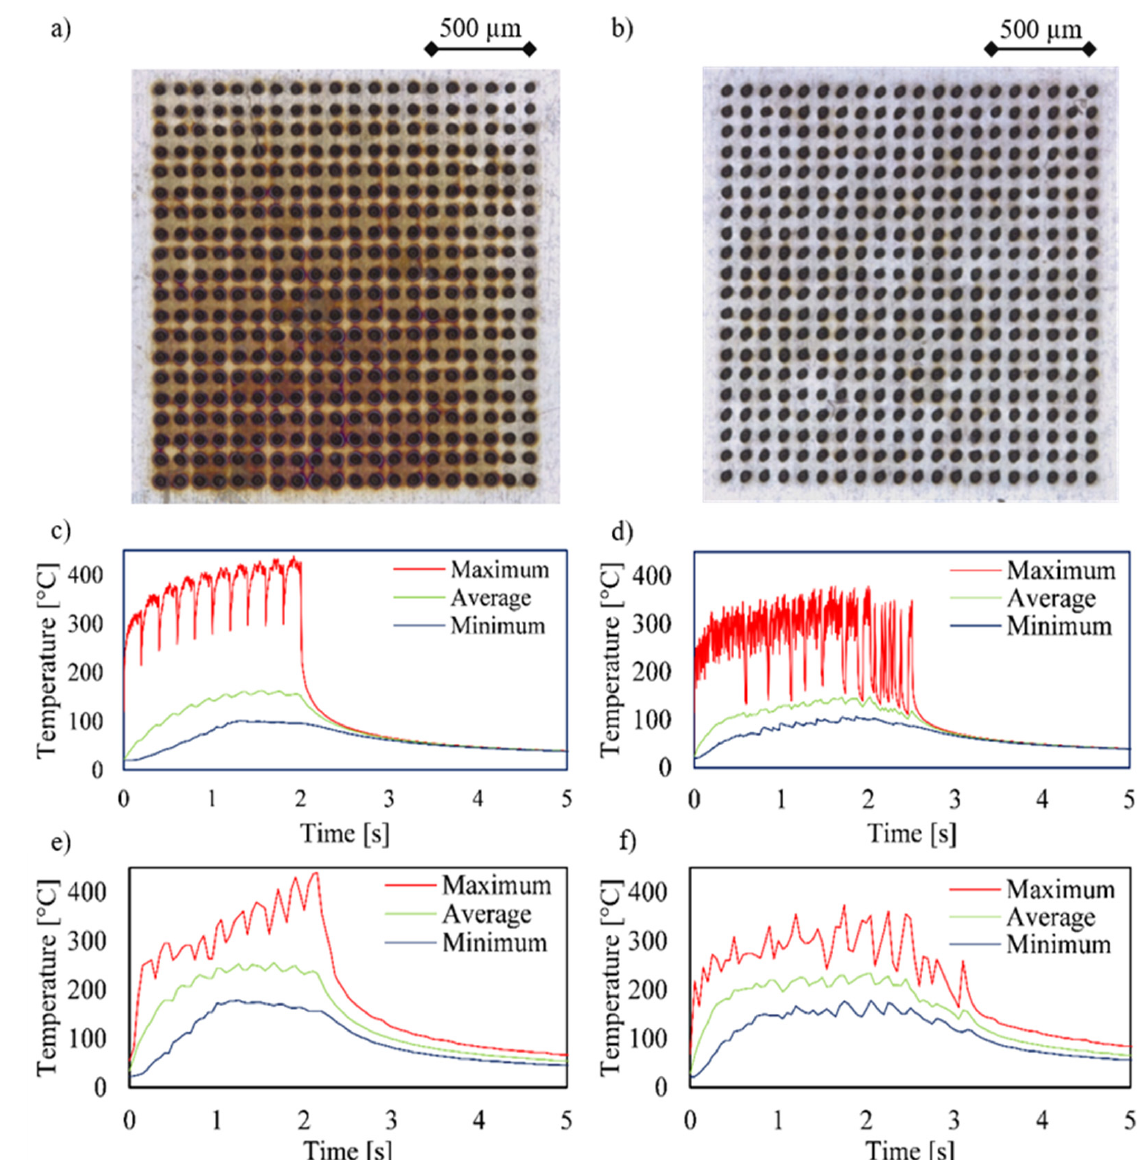
Figure 5. Microscope images ( a , b ), simulated temperature plots from COMSOL ( c , d ), and temperature plots ( e , f ) of a 20 × 20 array with 100 µm separation distance taken with a thermal imaging camera. The holes were drilled using a 2 × 2 beam splitter and a power of 2.3 W with a repetition rate of 60 kHz. ( a , c , e ) correspond to the standard drilling sequence, ( b , d , f ) to the optimized drilling sequence.